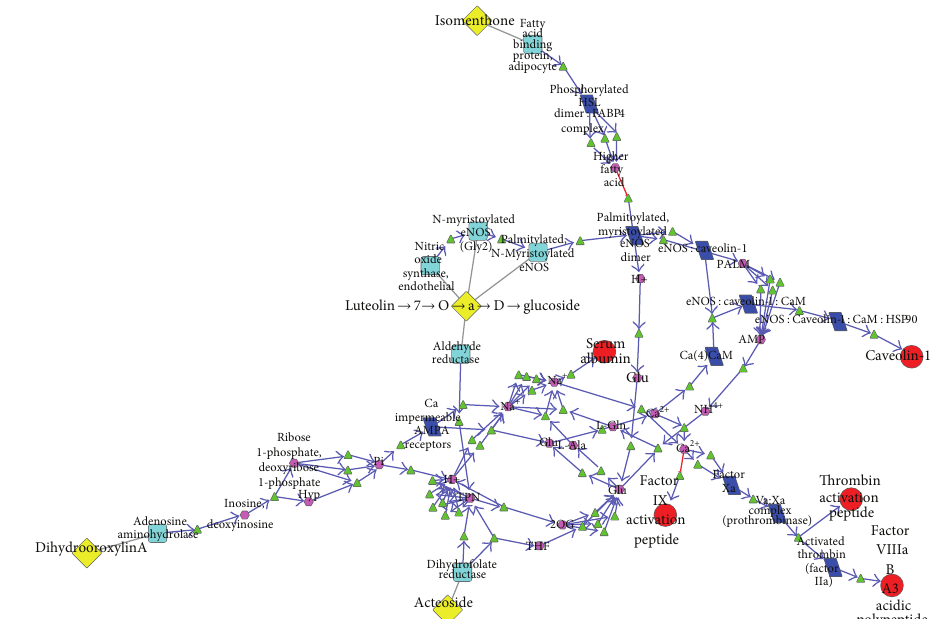
Figure 5: The antipneumonia biological network of